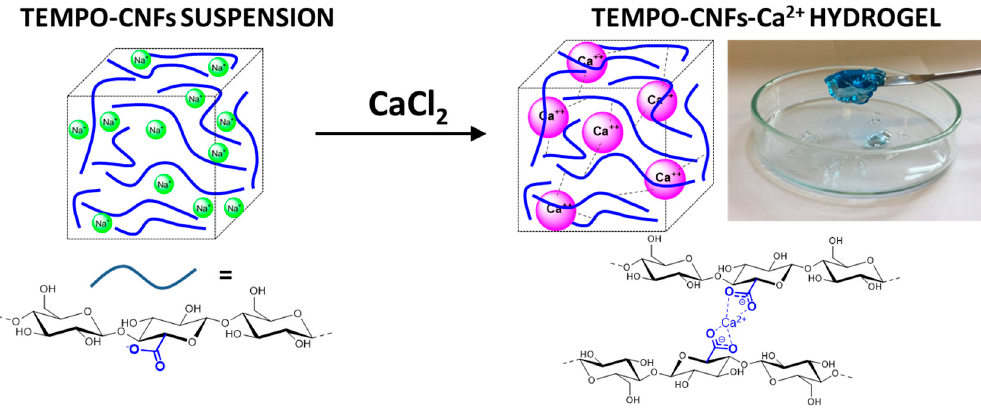
Figure 1. Production scheme of 2,2,6,6-tetramethylpiperidine 1-oxyl oxidized and ultra-sonicated cellulose nanofibers (TOUS-CNFs)-Ca 2+ hydrogels.